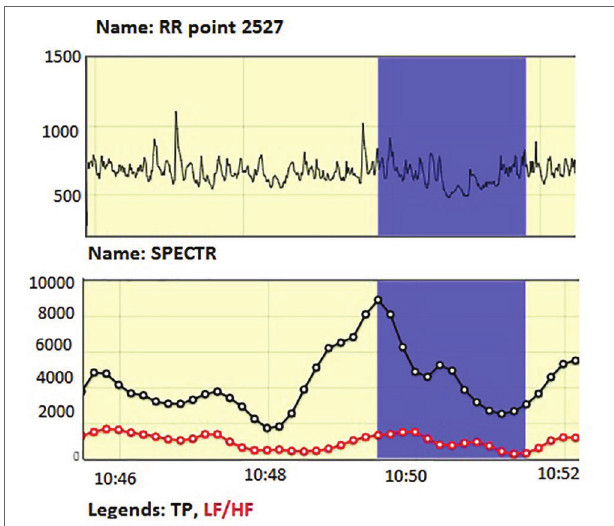
FIGURE 1 | Graphics showing a stress response pattern of a student writing the class test. Beginning of the stress at approximately 10:47:48, ending at 10:49:48. Total duration 2 min (120 s).